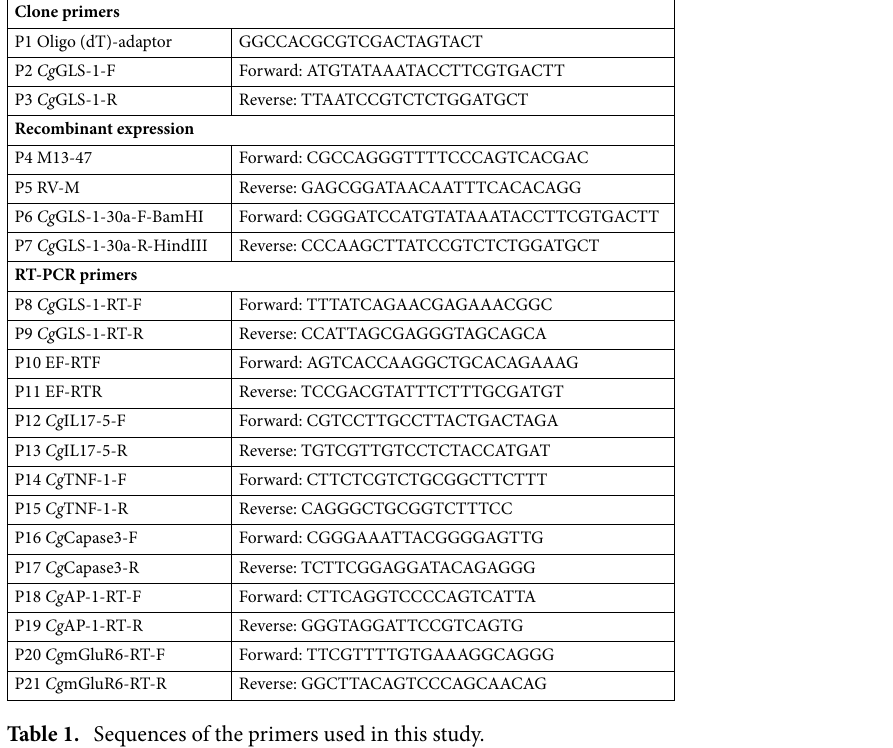
Table 1. Sequences of the primers used in this